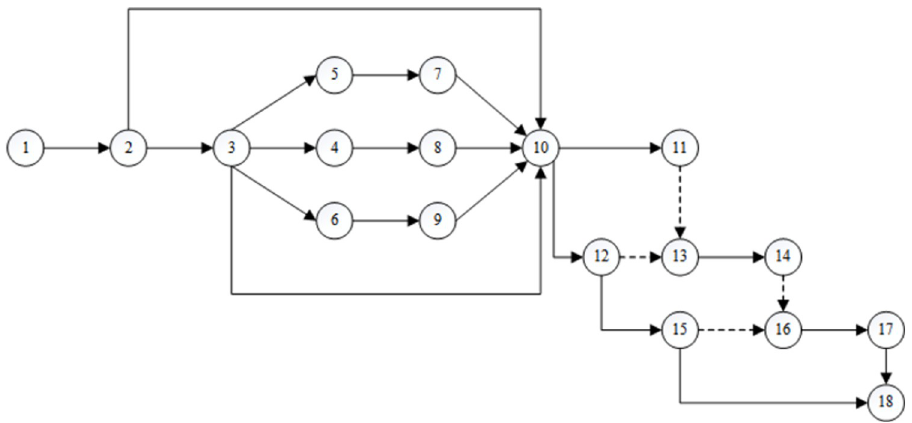
Fig 3. Project double-generation network